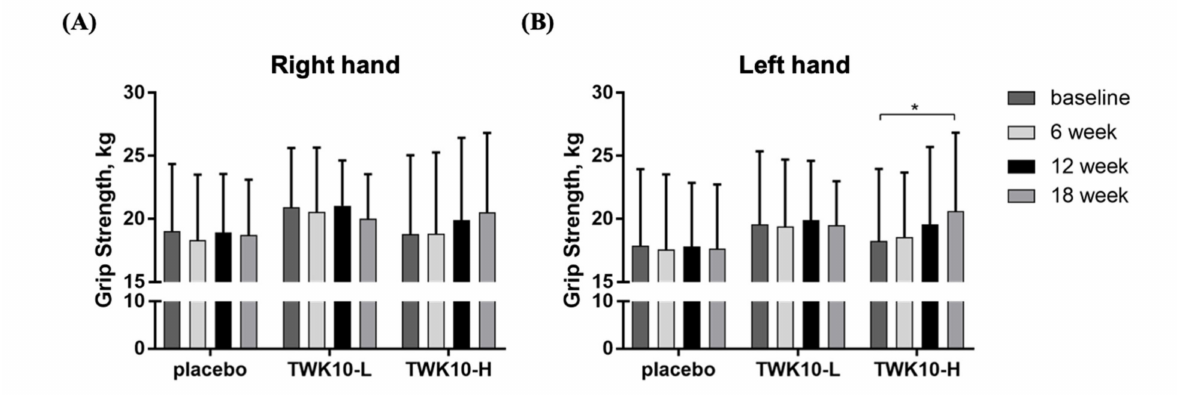
Figure 2. Effect of L. plantarum TWK10 supplementation on the ( A ) right and ( B ) left hand grip strength of elderly participants. Data are expressed as mean ± SD. * p < 0.05 vs. baseline.